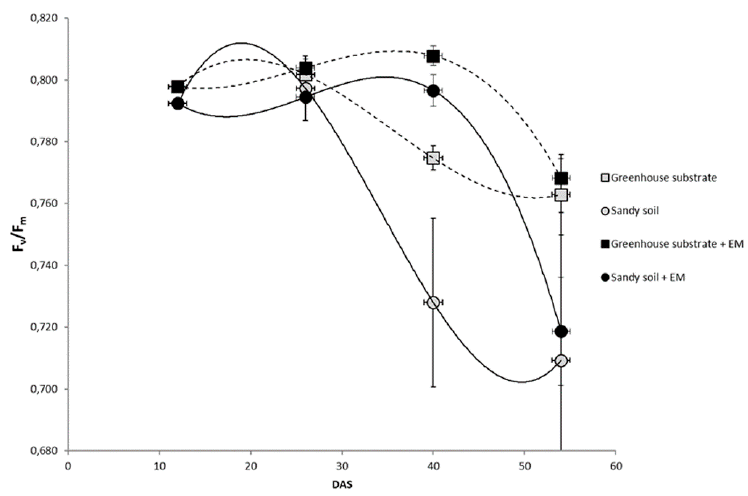
Figure 1. Effects of EM (effective microorganisms) treatments on maximum efficiency of photosystem II (F v /F m ) of bean plants grown on greenhouse substrate and sandy soil. DAS, days after sowing. Results are expressed as mean ( n = 15) and error bars indicate the standard deviation (SD).